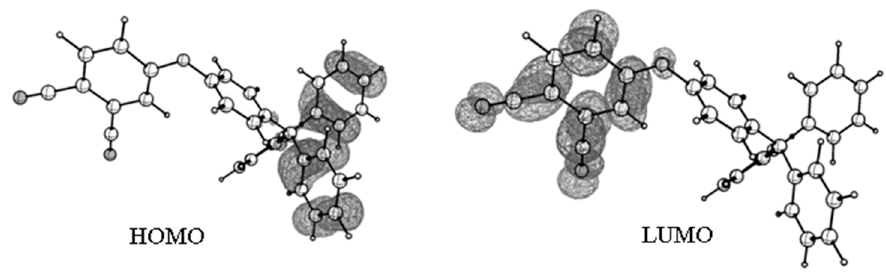
Figure 6. View of the frontier MOs of cis -conformer II.